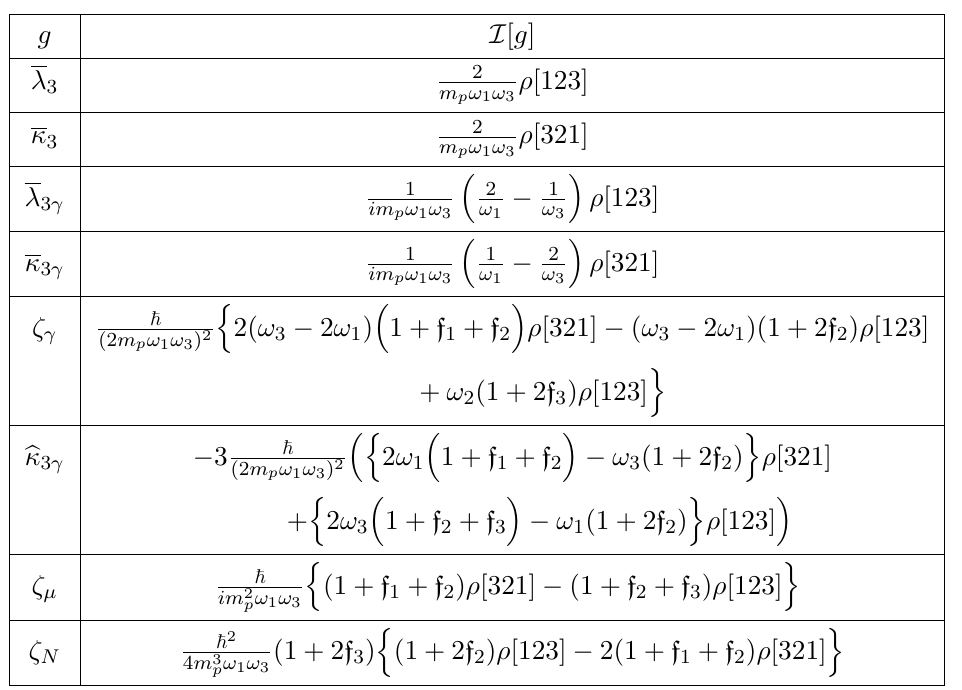
Table 5 . Sum rules for Coupling (Thermal